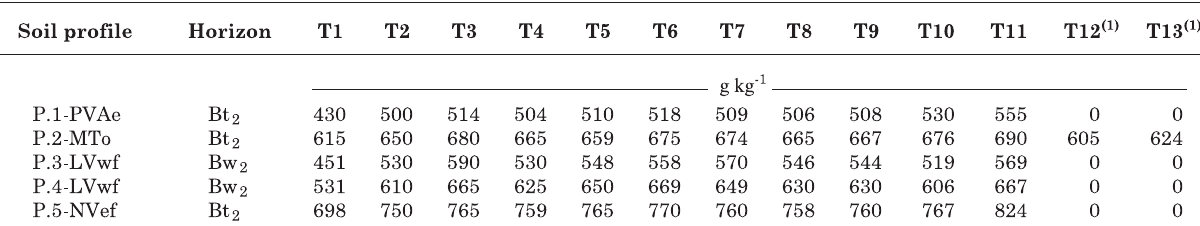
Table 3. Mean clay contents determined in samples from the horizon B of five soils, applying 13 particle dispersion treatments